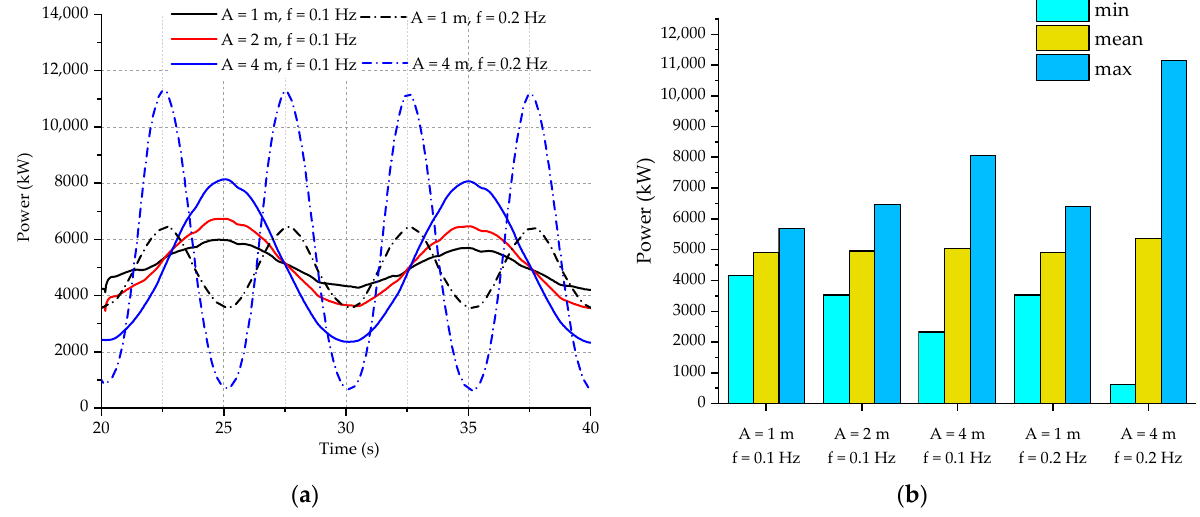
Figure 9. Power performance under surge motion. ( a ) Power variation versus time; ( b ) the average and extreme power.